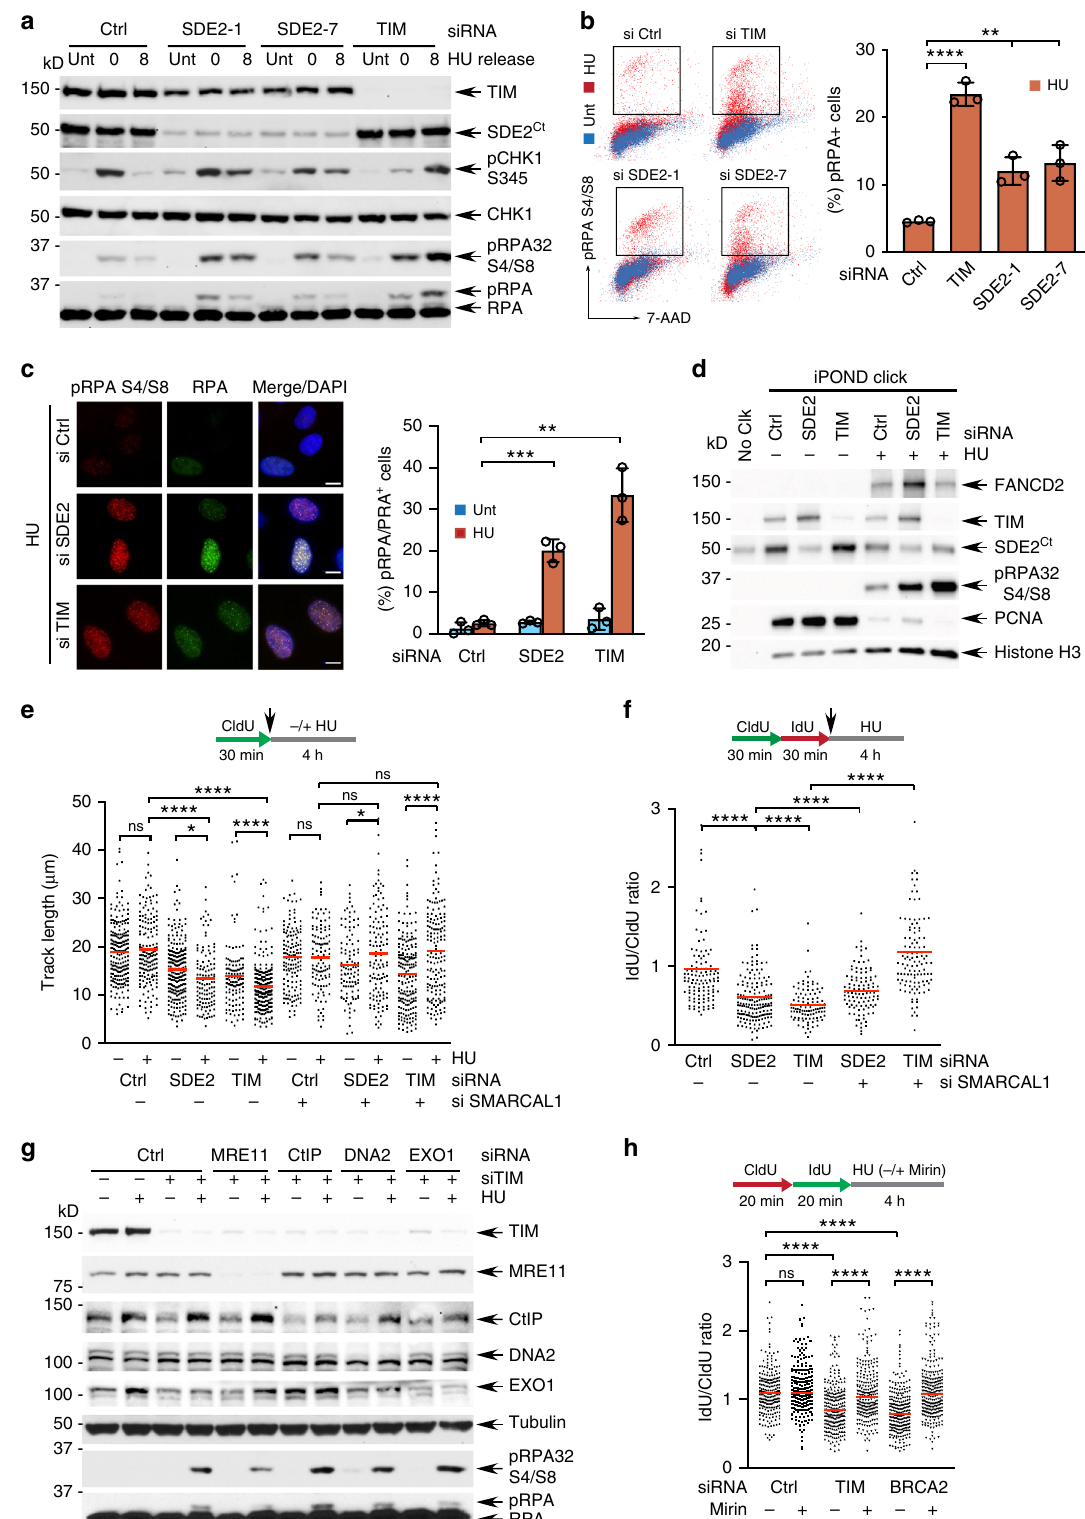
TIM localization at EdU-labeled forks, con fi rming that SDE2 recruits TIM and promotes its localization to replication forks (Fig. 7c; Supplementary Fig. 7b). Furthermore, cells reconstituted with the Δ SDE2 mutant were not able to restore replication track lengths in comparison to WT SDE2, suggesting that the SDE2- TIM interaction is necessary for ef fi cient fork